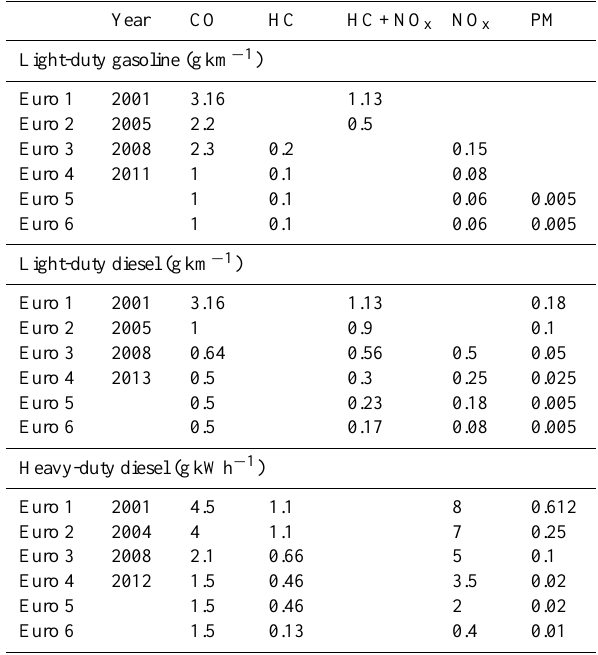
Table 1. Implementation years and national vehicle emission stan- dards for all sales in